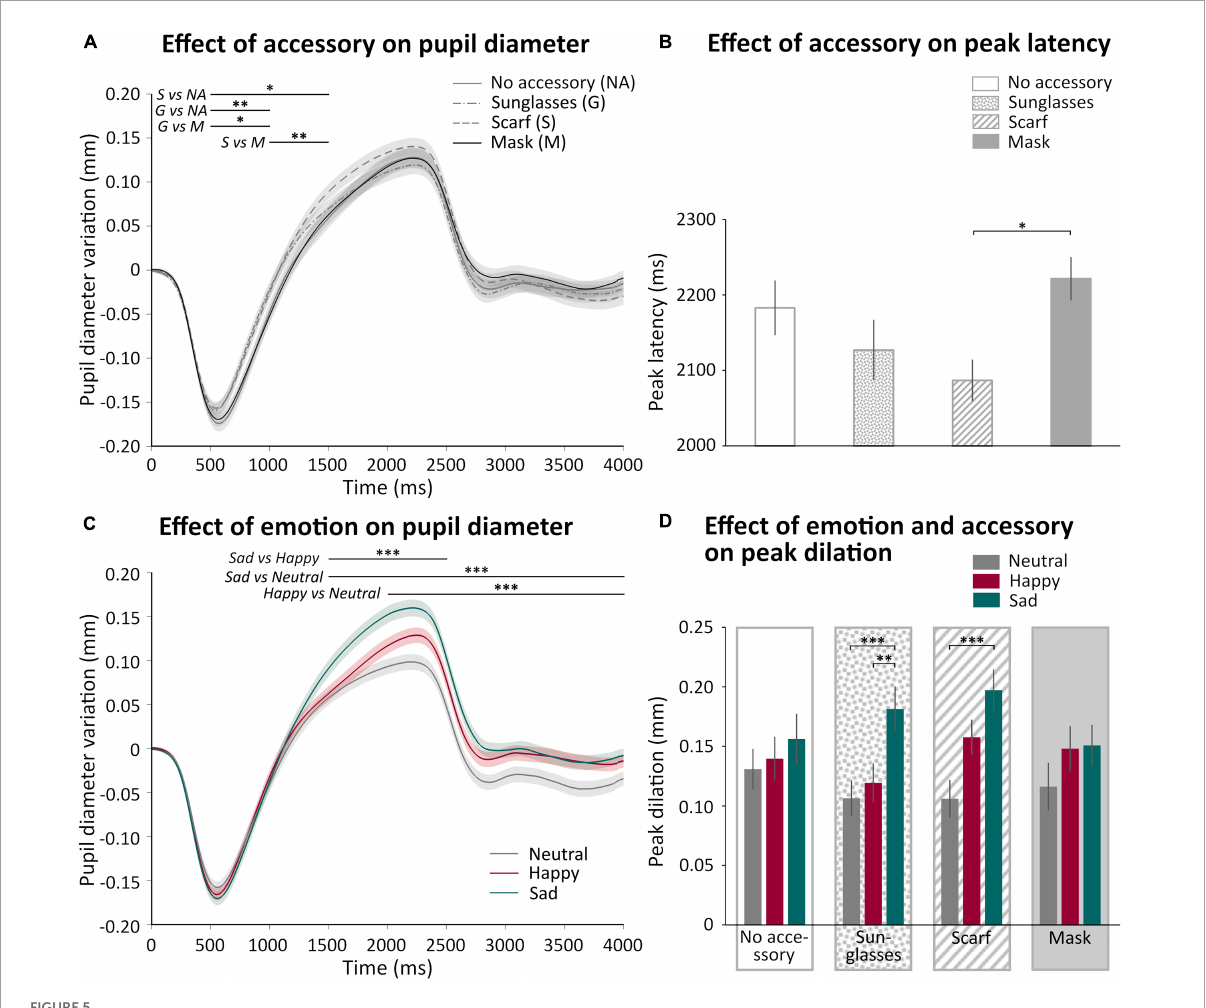
FIGURE5 Effect of accessory and emotion on pupil variations. (A) Mean ( ± standard error) pupil variation (mm) of all participant during 4 s according to accessory (no accessory NA: solid gray, sunglasses G: dash point gray, scarf S: dashed gray, and mask M: solid black). (B) Mean ( ± standard error) peak latency (ms) of all participant according to accessory (no accessory: white; sunglasses: dotted; scarf: hatched; mask: gray). (C) Mean ( ± standard error) pupil variation (mm) of all participant during 4 s according to emotion (neutral: gray; happy: burgundy; sad: green). (D) Mean ( ± standard error) peak dilation (mm) of all participant according to accessory (no accessory: white, first panel; sunglasses: dotted, second panel; scarf: hatched, third panel; mask: gray, last panel) and emotion (neutral: gray, left columns; happy: burgundy, middle columns; sad: green, right columns). ∗ p < 0.05; ∗∗ p < 0.01; ∗∗∗ p <